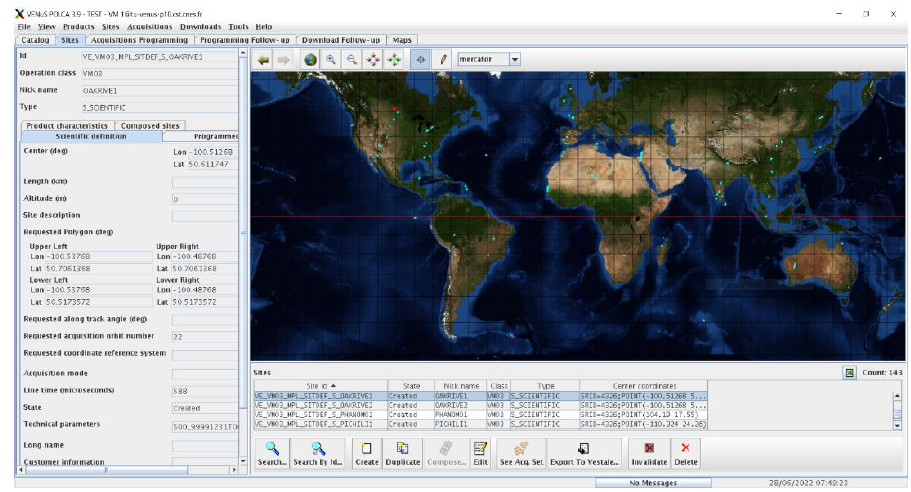
Figure 32. POLCA sites definition.